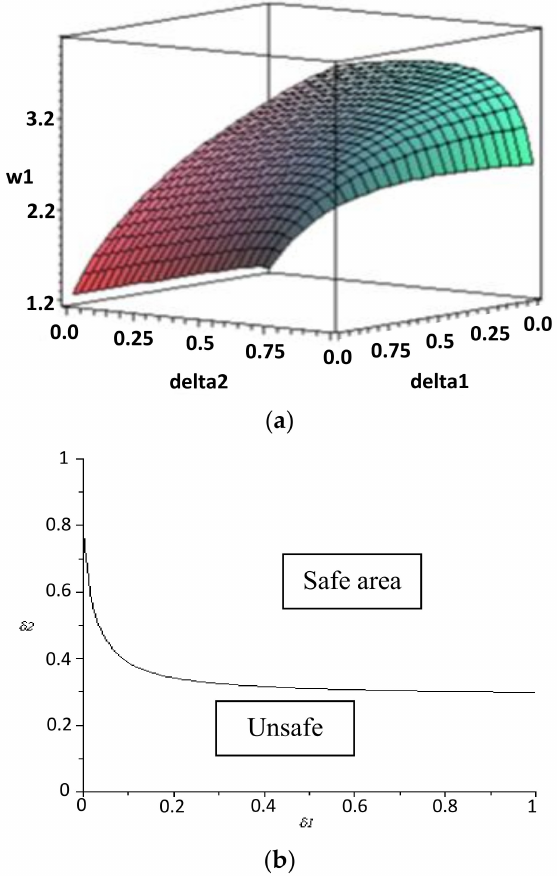
Figure 5. ( a ) Evolution of natural frequency ω 1 as a function of different values of δ 1 and δ 2 . ( b ) Safe and unsafe areas defined by ω 1 >